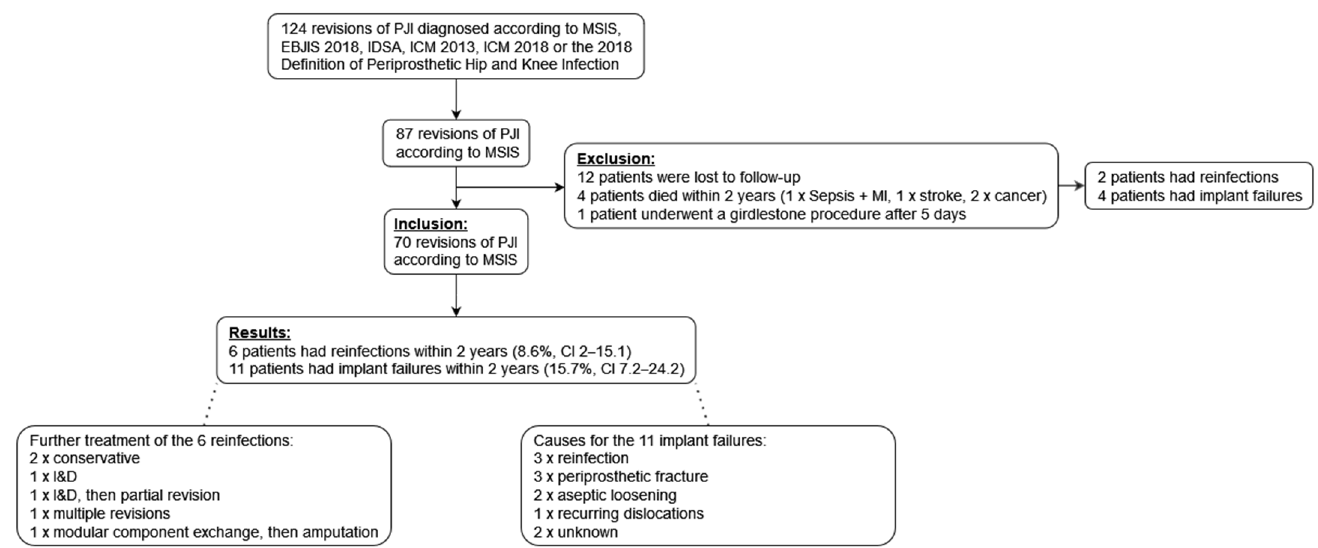
Figure 1. Flowchart illustrating the inclusion, exclusion and results of patients in this study. Abbre- viations: MI, myocardial infarction; I&D, irrigation and debridement.